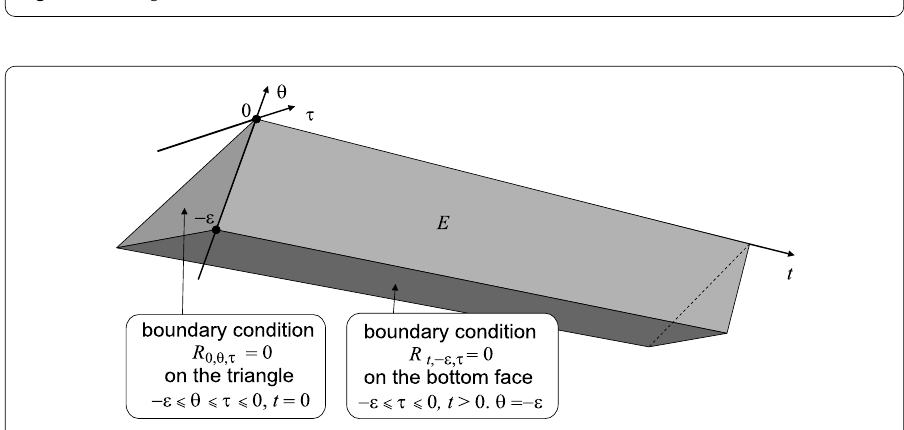
Figure 1 The region D